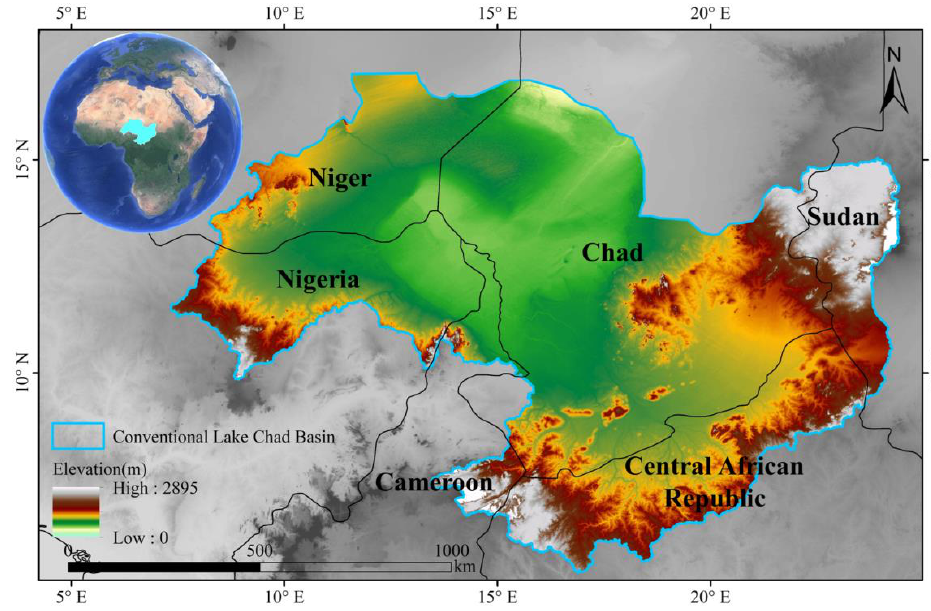
Figure 1. Schematic of the study